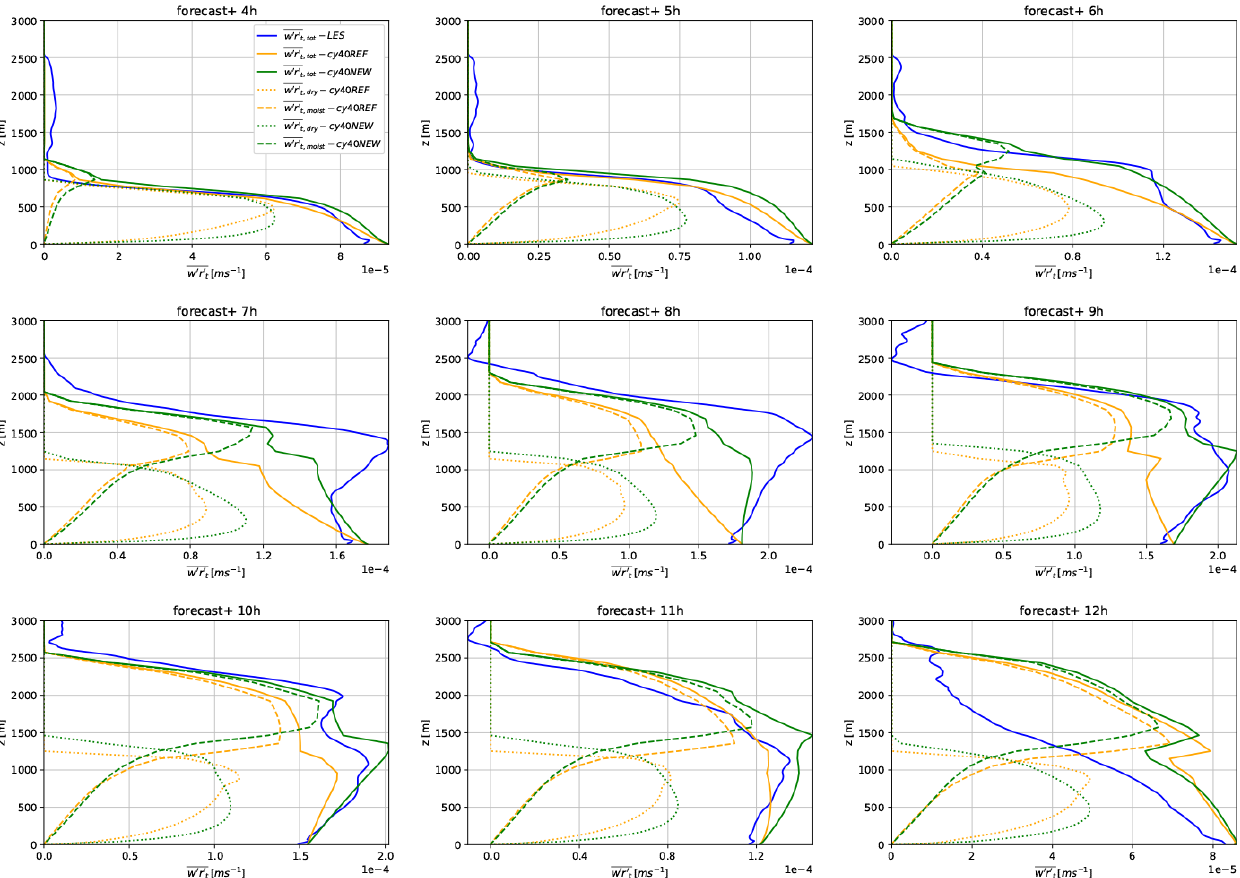
Figure 5. Total turbulent transport and transport by the dry and moist updraft (ms − 1 ) of the mixing ratio total humidity r t during all convective hours of the ARM case, corresponding to simulation hours at + 4 to + 12h. Plotted is total turbulent transport of cy40REF (orange solid line), cy40NEW (green solid line), and the total turbulent transport by the LES (blue). The dry updraft transport is shown as a dotted line (cy40REF in orange; cy40NEW in green). Similarly, the dashed lines show the transport by the moist updraft. Note that the x -axis scale is not